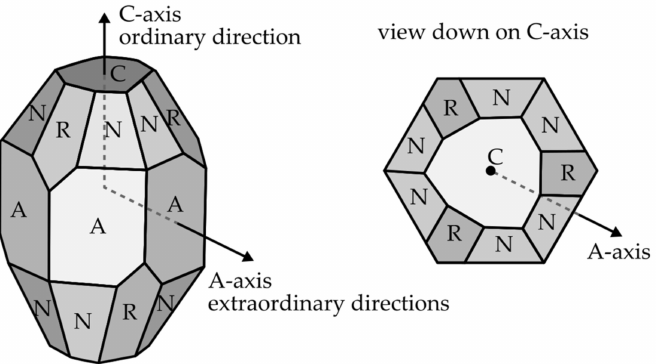
Figure 1. Illustration of the sapphire crystal structure. A,C,N and R indicate the respective crys- tal